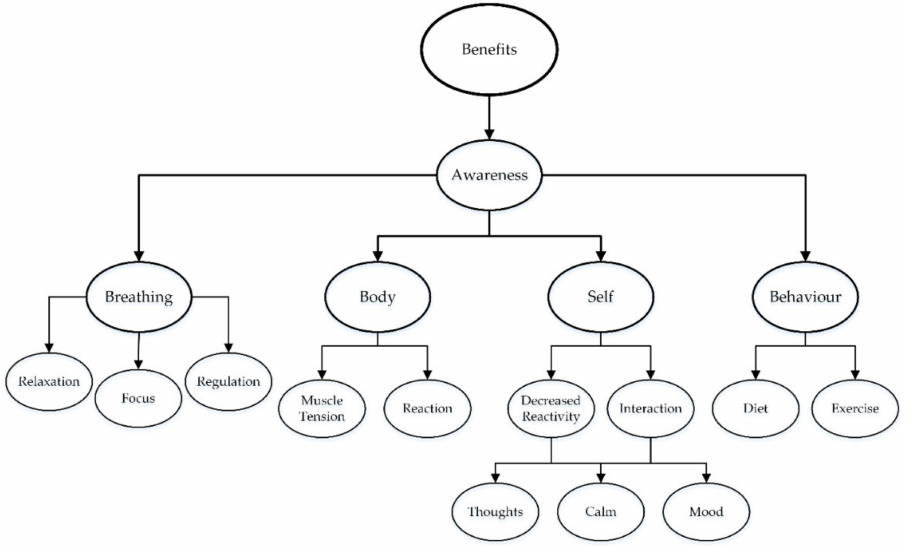
Figure 3. Coding of themes for the domain-reported